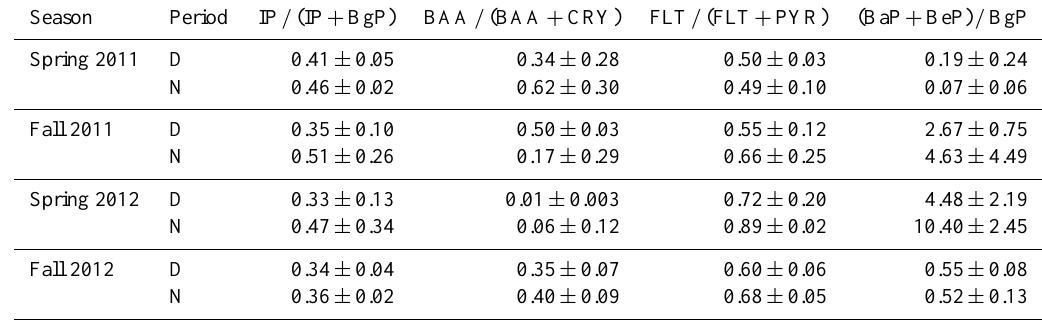
Table 4. Average diagnostic ratios of PAHs in MMA. D represents daytime and N represents nighttime. Season